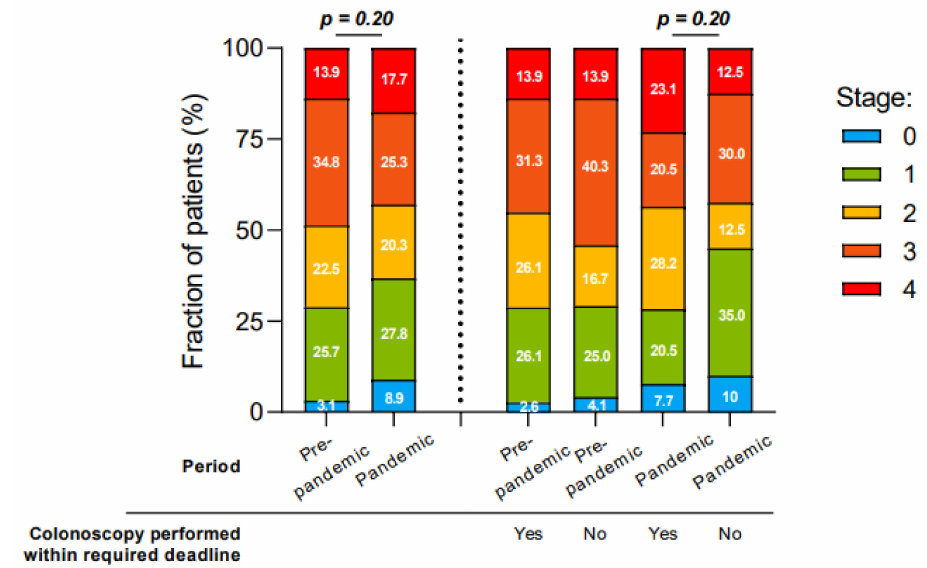
Figure 3. Impact of the COVID-19 pandemic on staging of CRC at